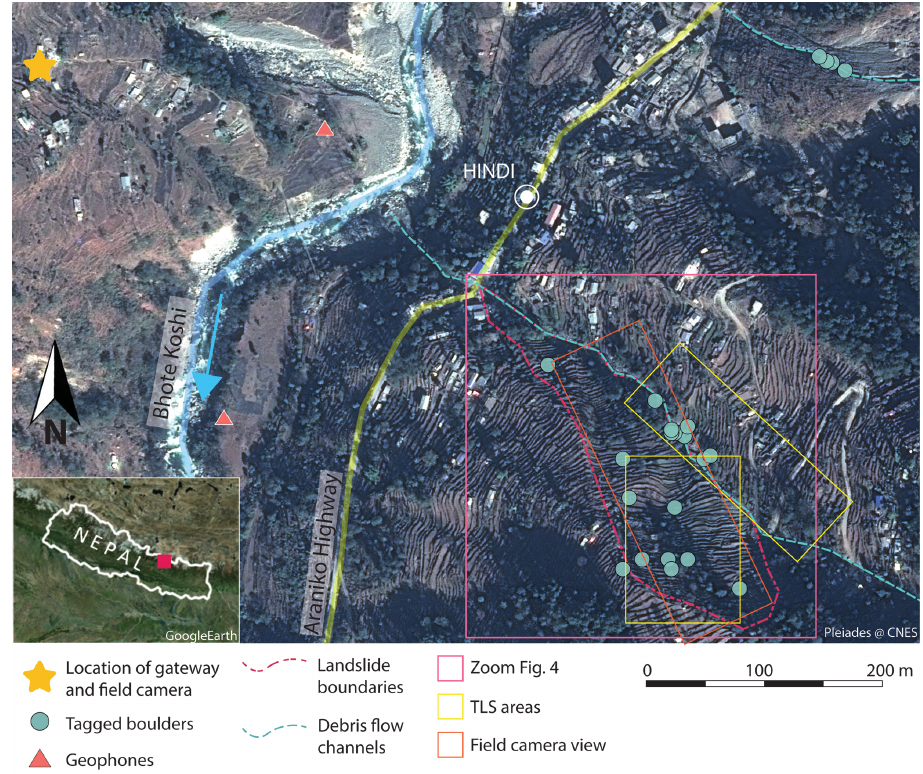
Figure 1. Overview of study area and network, including three tagged sites (two debris flow channels and a landslide body). Red box: zoom of two tagged sites. Yellow boxes: terrestrial laser scanner areas. Orange box: field view of the field camera. Image: Pleiades (CEOS Landslides